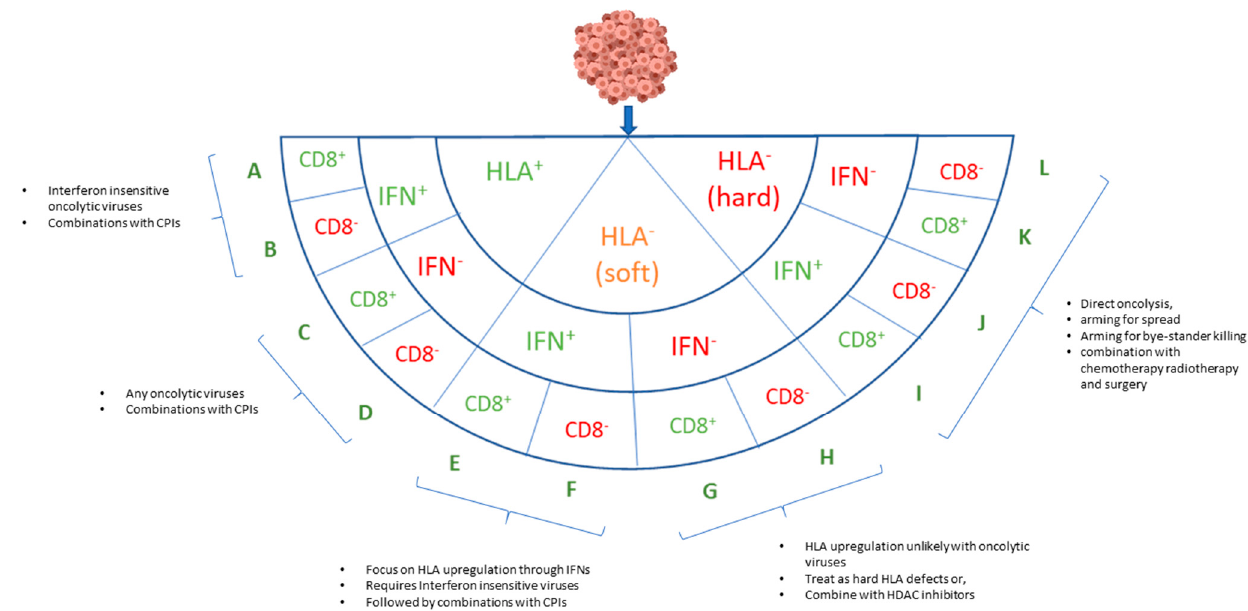
Figure 2. Simplified model of immunological phenotypes from the perspective of oncolytic therapy. HLA + cancers (A–D) have a high potential for immune responses including oncolytic strategies to foster in situ vaccination and combinations with checkpoint inhibitors (CPIs). Cancers with a HLA − (soft) phenotype (E–H) require conversion to HLA + before an adaptive immune response is likely to succeed. One of the most effective ways to restore HLA expression is through interferons (IFN), which are usually expected to be an inherent byproduct of oncolysis and immunogenic cell death. Understanding the IFN status of cancer cells is of particular importance in the context of reversible HLA defects and oncolytic viruses. Cancer cells need to be IFN-competent to allow HLA upregulation, but these cells are a poor target for oncolytic viruses that are designed to selectively replicate in IFN-defective cells. With functional HLA status restored, CD8 + infiltration becomes an important variable. Some viruses are vulnerable to lymphocytes by design, exploiting HLA defects or immune exclusion in order to spread. Drawing lymphocytes into the tumor is an essential part of the adaptive immune response and a forte of oncolytic viruses, however lymphocytes may also eliminate some oncolytic vectors prematurely. Cancers with molecular hard defects (HLA − ; categories I–L) or indeed soft HLA deficiencies that cannot be restored, may be difficult to treat with any therapy that relies on the adaptive immune response for efficacy. For these cancers, direct oncolysis combined with conventional cytotoxic chemoradiotherapy or the use of HLA independent killing strategies, for example encoding bi-specific T-cell engagers, may be more appropriate. Finally, it is worth noting that tumor heterogeneity means that different phenotypes may well occur within different regions of the same tumor. HDAC: histone deacetylase.